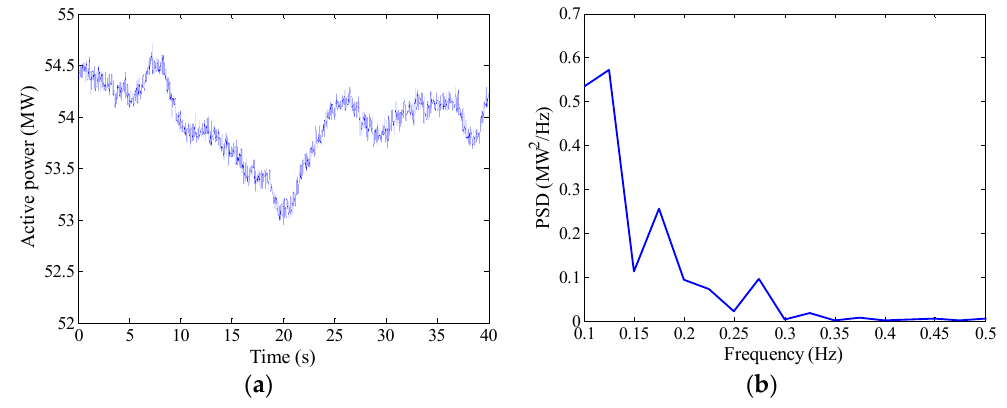
Figure 6. Properties of wind power fluctuation of 40 s in both time and frequency domains. ( a ) Measured fluctuation of the wind power; ( b ) Corresponding PSD.